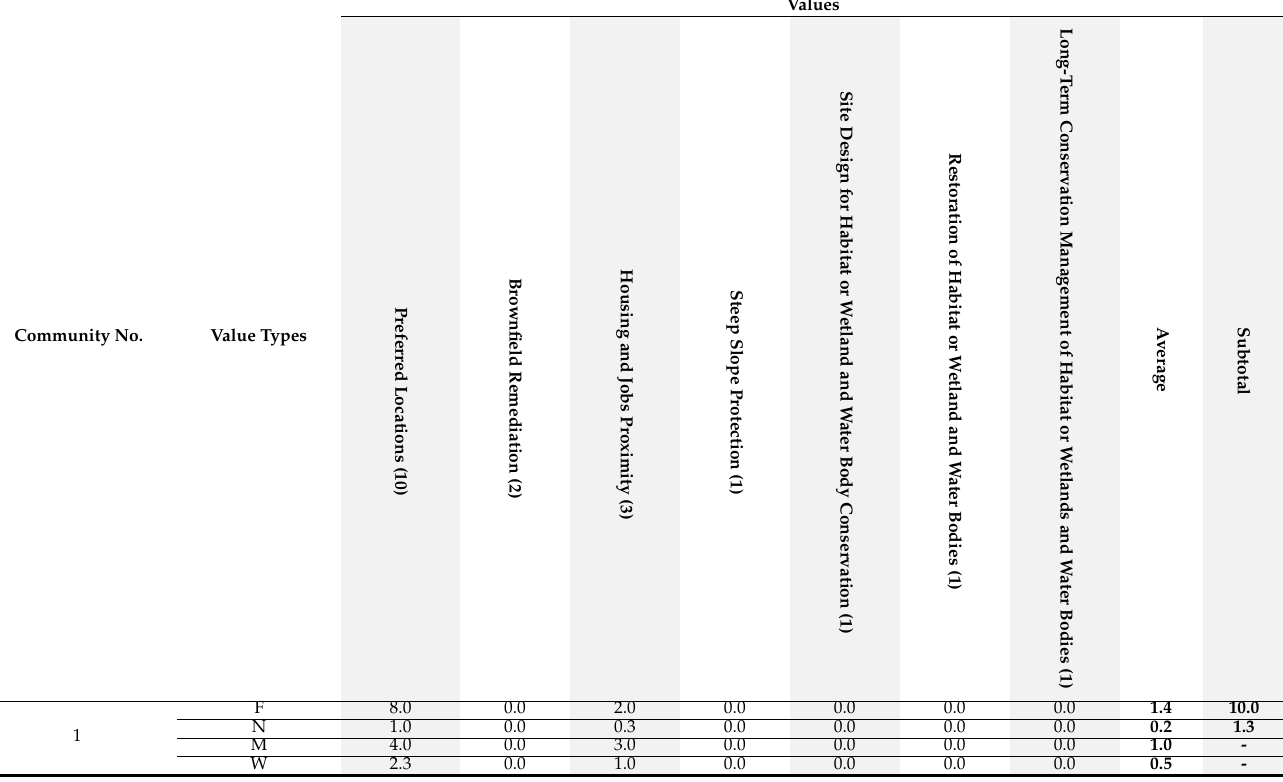
Table 2. Scoring results of smart location &